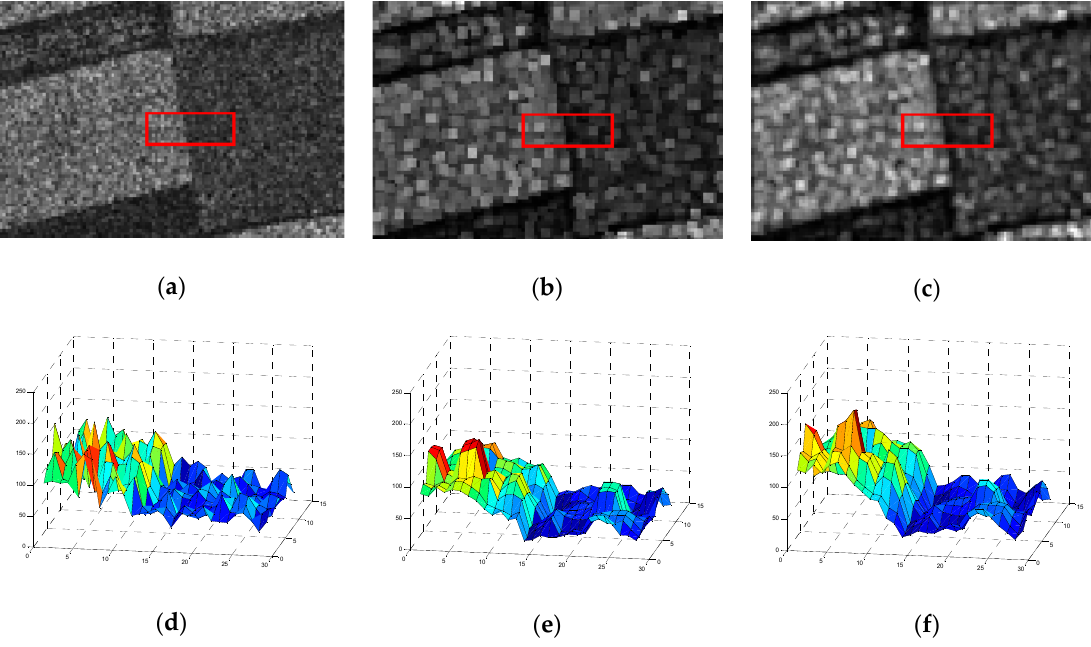
Figure 5. ( a ) Original SAR image; ( b ) Saliency map by LCM; ( c ) Saliency map by GLCM; ( d-f ) 3-D surface intensity map of regions in red rectangle: ( d ) The original map; ( e ) Saliency map by LCM; ( f ) Saliency map by GLCM.